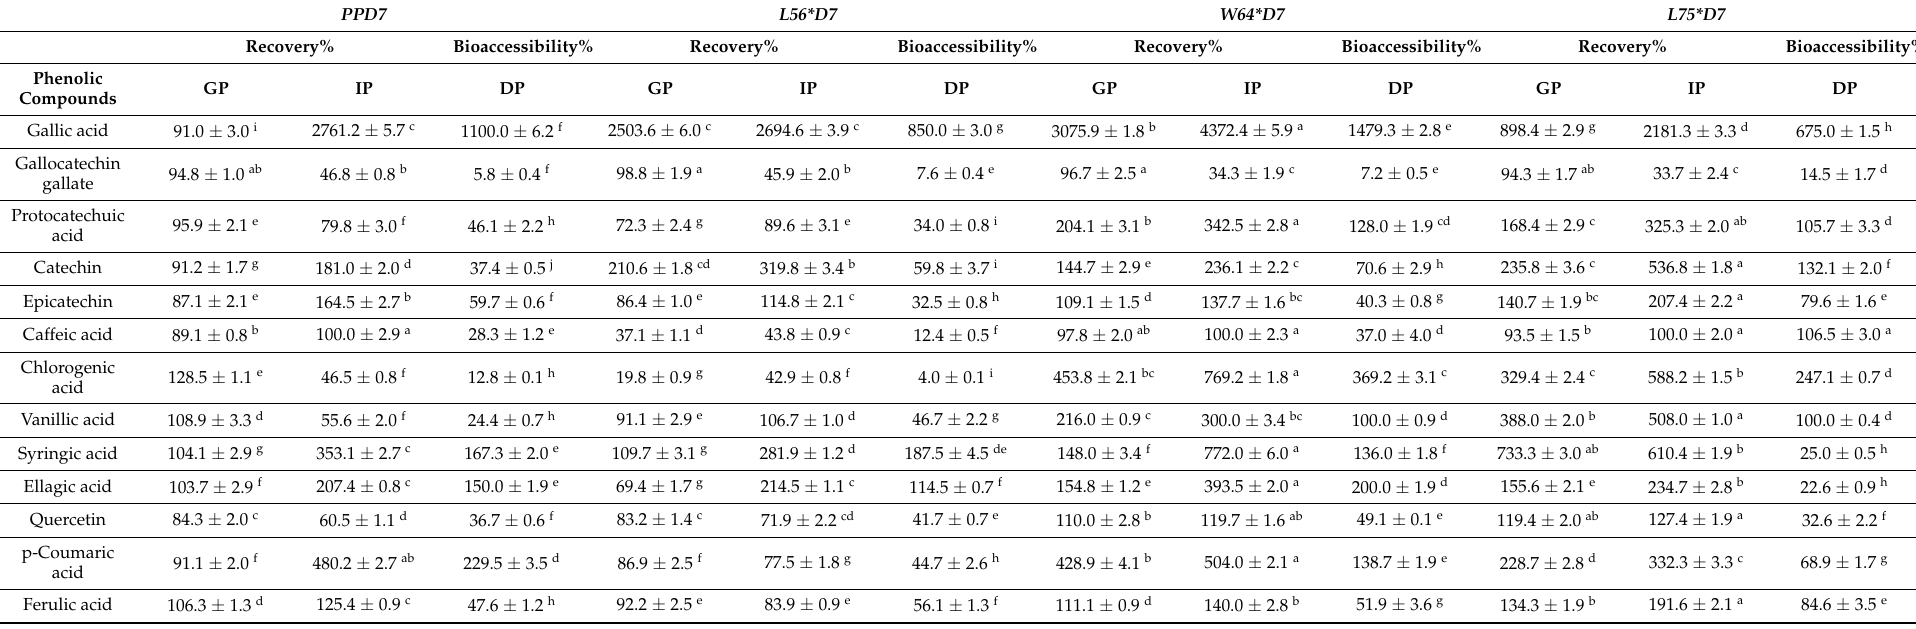
Table 5. Recovery and bioaccessibility (%) of different phenolic compounds in fermented and non-fermented papaya